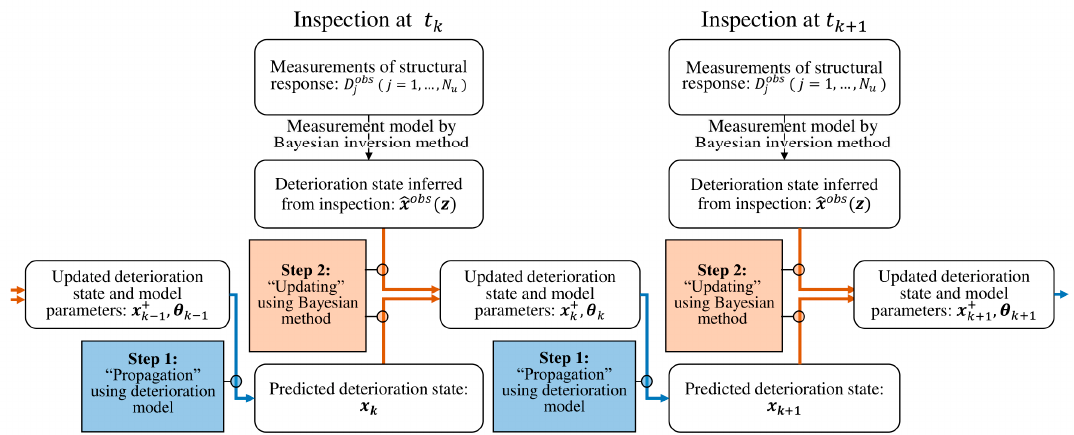
Figure 3. Recursive particle filter-based framework to monitor and predict spatiotemporal progress of structural deterioration.